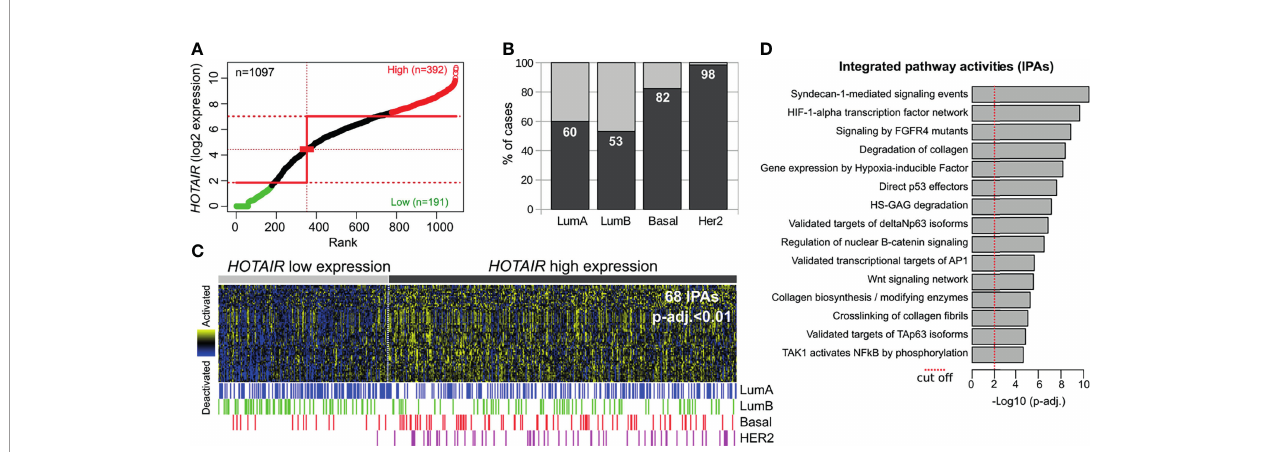
FIGURE 5 | HOTAIR expression and pathway activity analysis in primary invasive breast carcinomas. (A) Primary breast carcinomas were divided into HOTAIR low or high expression levels based on the StepMiner algorithm using TCGA RNA-seq datasets obtained from the UCSC Xena resource (https://xenabrowser.net/). (B) Percentage of cases with high or low HOTAIR expression among intrinsic subtypes showing a consistent up-regulation in basal-like and HER2 subtypes compared with luminal-like tumors. (C) Heat map with the 68 signi fi cantly activated PARADIGM Integrated Pathways Activities (IPAs) among HOTAIR high expression tumors (p-adj.<0.01). (D) Bar plot of the top fi fteen activated pathways determined by PARADIGM algorithm in primary invasive breast carcinomas with HOTAIR overexpression.